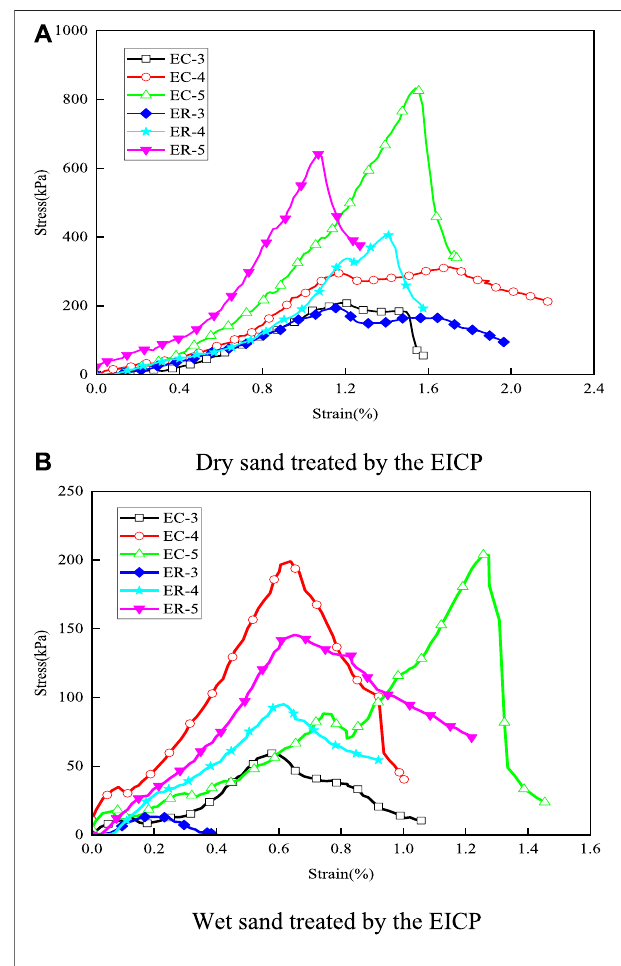
FIGURE 2 | Compressive strength and calcium carbonate content of sand column with different treatment methods and times.